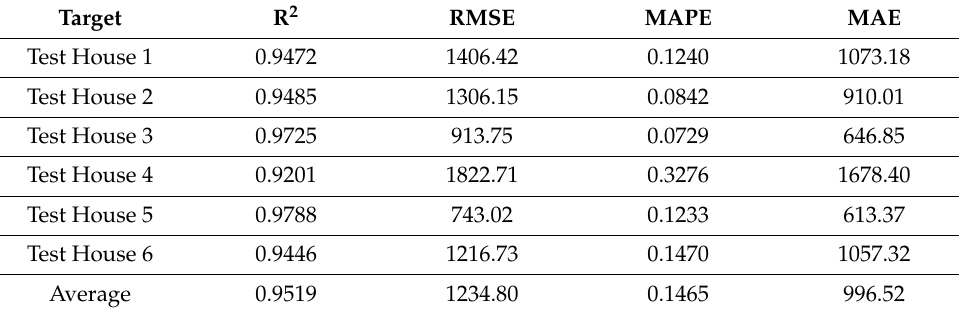
Table 6. Model prediction evaluation parameters for testing